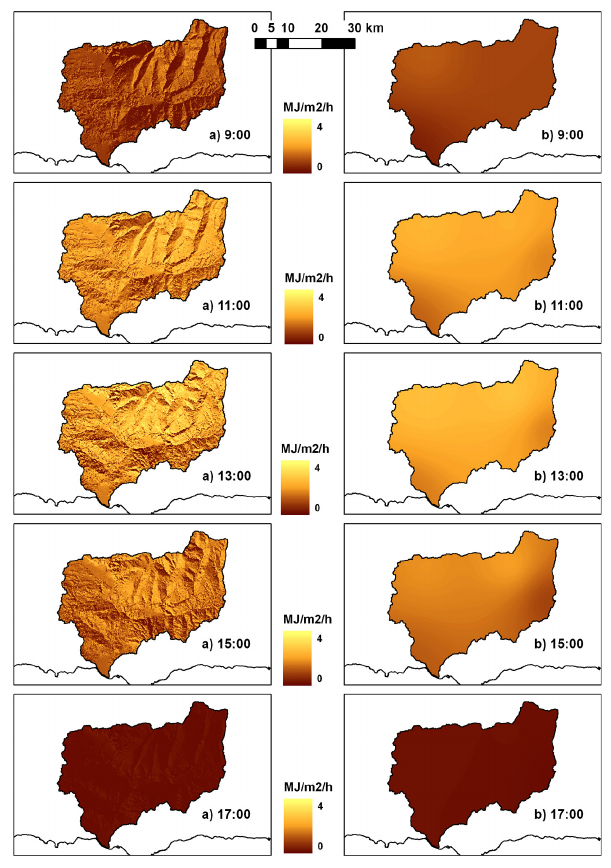
Fig. 2. Hourly global radiation (a) topographically corrected vs. (b) IDW interpolated (20 November 2004).